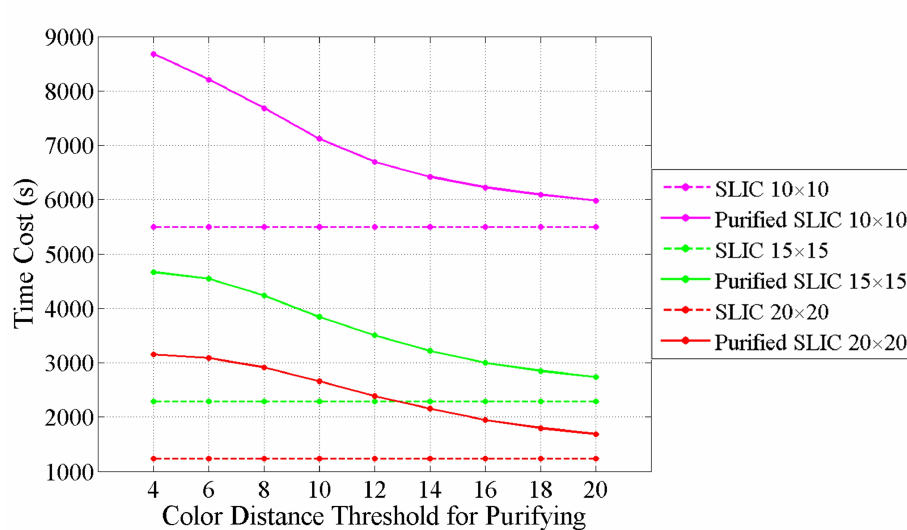
Figure 12. The influence of the color distance threshold T for time